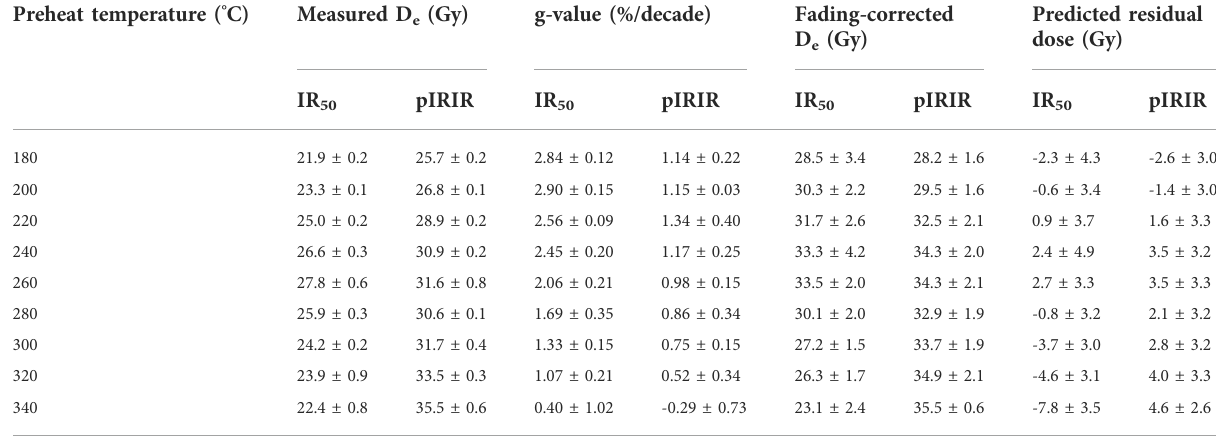
TABLE 2 The measured IR 50 and pIRIR D e s, g-values and the “ predicted residual dose ” (fading-corrected D e minus expected D e ) at various temperatures.ThemeasuredD e swerepreviouslypresentedinZhangetal.(2015a).TheexpectedD e of30.8±2.5 Gyiscalculatedfromthequartz OSL age of 6.3 ± 0.4 ka (Zhang et al., 2015b).